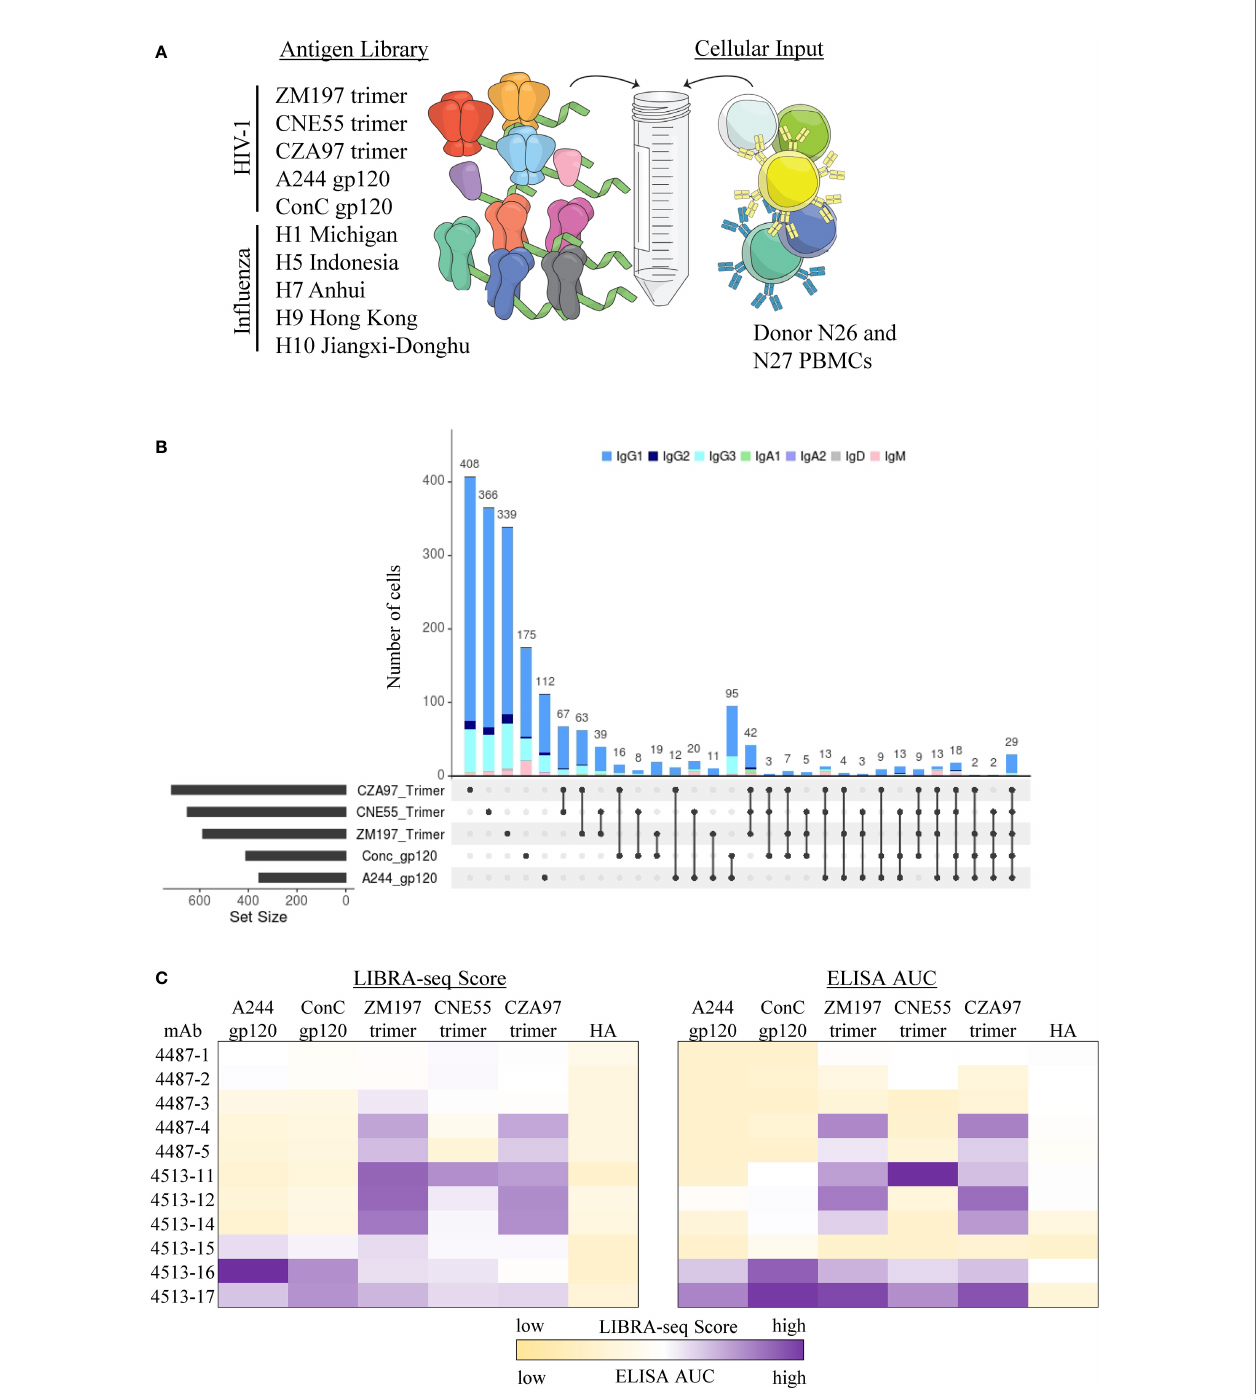
FIGURE 3 | Identi fi cation of con fi rmational speci fi c antibodies from LIBRA-seq with epitope mapping. (A) Schematic of DNA barcoded antigens used in LIBRA-seq with epitope mapping assays. (B) Upset plot for all B cells with LIBRA-seq score ≥ 1 against different HIV-1 antigen combinations. On the X-axis, each column represents a different combination of antigens (rows), showing which antigens are part of a given combination (displayed by fi lled circles), with the bar height corresponding to the number of B cells identi fi ed to be reactive with the given antigen combination. Each combination is mutually exclusive. The total number of B cells predictive to be reactive with each individual antigen is indicated as a horizontal bar at the bottom left of each subpanel. Isotype for each antibody is depicted by different colors. (C) LIBRA-seq scores and ELISA AUC values for each antibody binding to HIV-1 trimer and monomer antigens. Scores are represented by heatmaps, with the lowest scores displayed as light yellow and the highest as purple. ELISA data are representative of at least two different experiments. LIBRA-seq score data shown for H9 Hong Kong 2009 HA and ELISA AUC data shown for A/New Caledonia/20/99 H1N1 (NC99) HA. ELISA binding curves are located in the